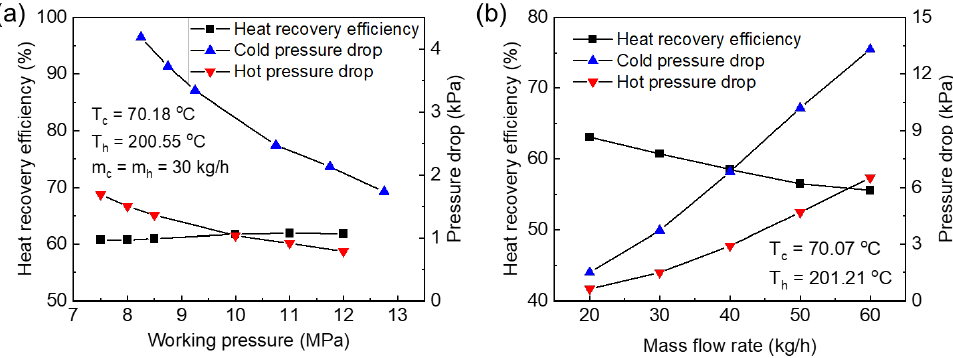
Figure 8. The effects of ( a ) the working pressure and ( b ) the mass flow rate on the efficiency and pressure drop.